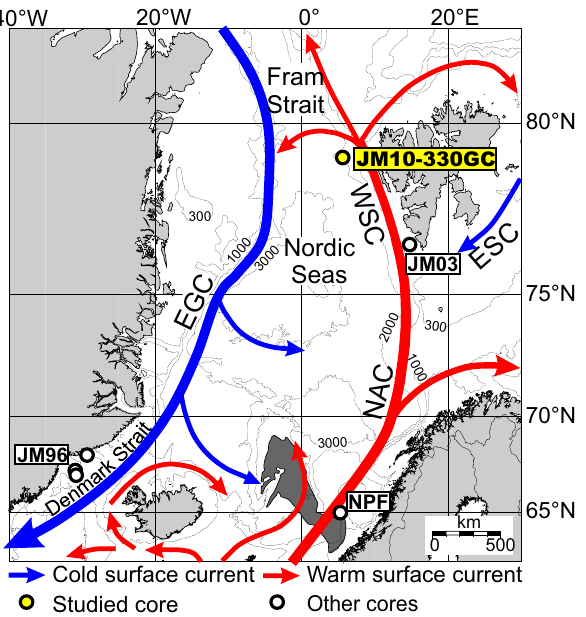
Figure 1. Bathymetric map of the Nordic Seas showing the ma- jor surface currents and the location of studied core JM10-330GC (yellow circle). Other cores are indicated with a white circle: JM96 cores are those described by Smith et al. (2001); JM03 represents core JM03-373PC2 used as reference core for the western Svalbard slope (Jessen et al., 2010); NPF cores are those described by Hill et al. (2012) in the Nyegga pockmark field next to the Storegga Slide (dark-grey area) on the mid-Norwegian margin. Abbrevia- tions: NAC, North Atlantic Current; WSC, West Spitsbergen Cur- rent; ESC, East Spitsbergen Current; EGC, East Greenland Current.